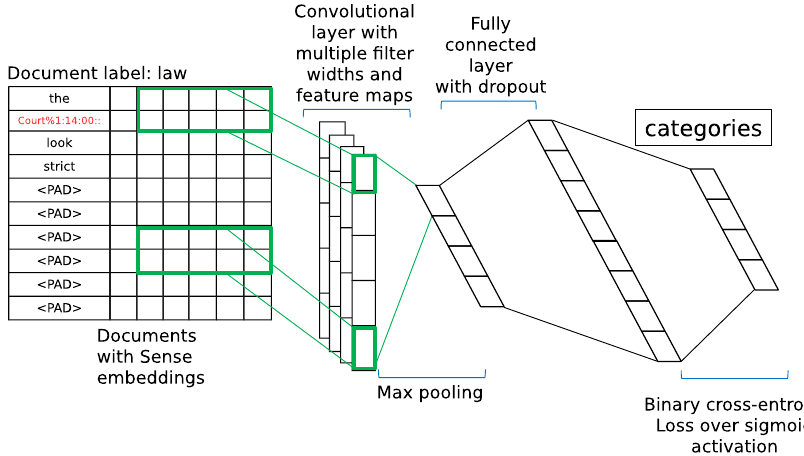
Figure 2. Convolutional Neural Network (CNN) model for text